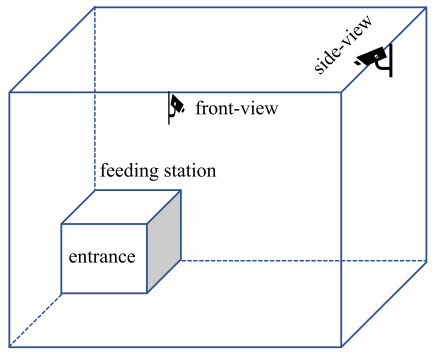
Figure 1. Pig pen layout and lens positions.